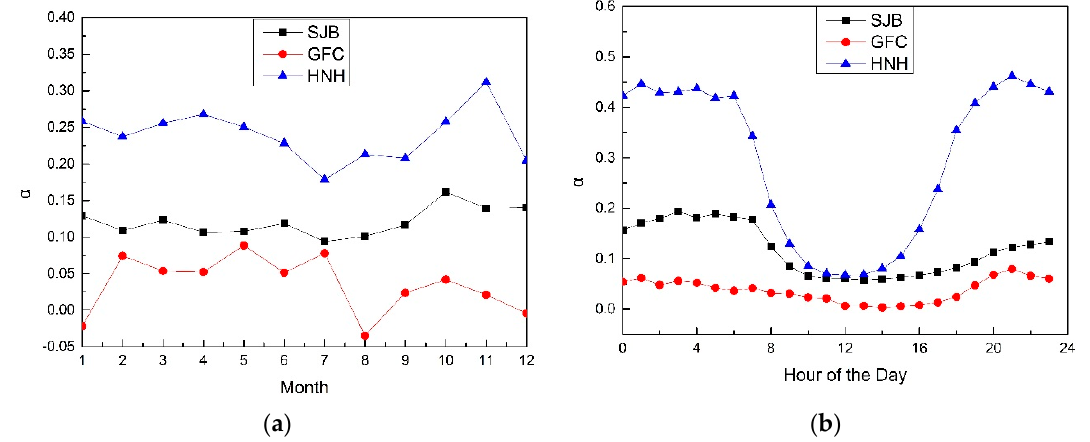
Figure 3. Monthly and diurnal variations of h 1– h 2 wind shear exponents in the three cases: ( a ) monthly variation; ( b ) diurnal variation.